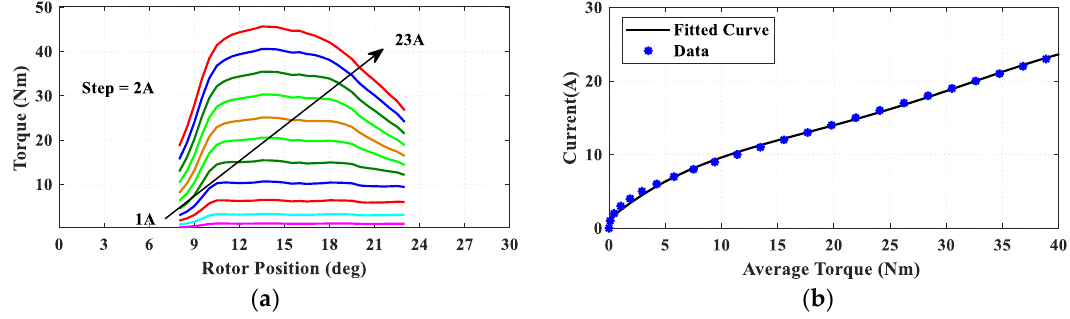
Figure 7. Torque to current conversion: ( a ) torque curves over 15°; ( b ) current versus average torque.